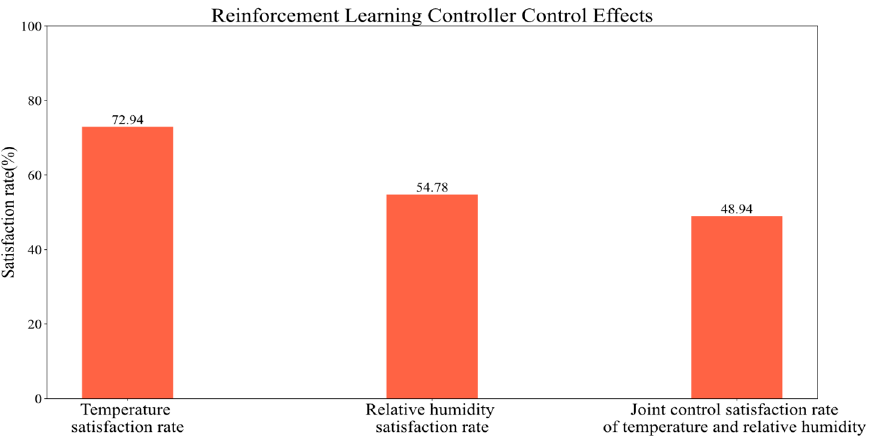
Figure 9. Reinforcement learning controller control effects.